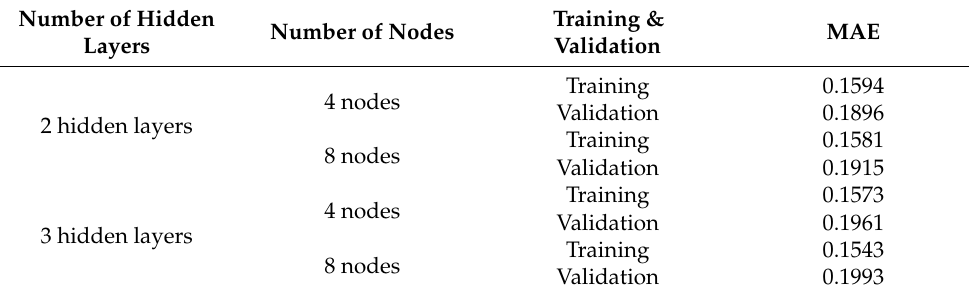
Table 1. Number of hidden layers and the MAE value for each node condition.